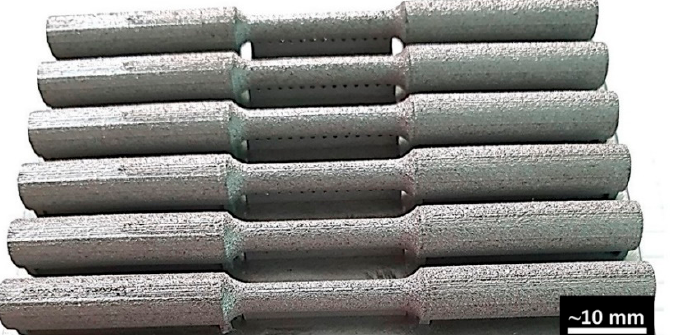
Figure A1. Image of some produced tensile specimens on the building platform of 90 × 90 mm 2 .